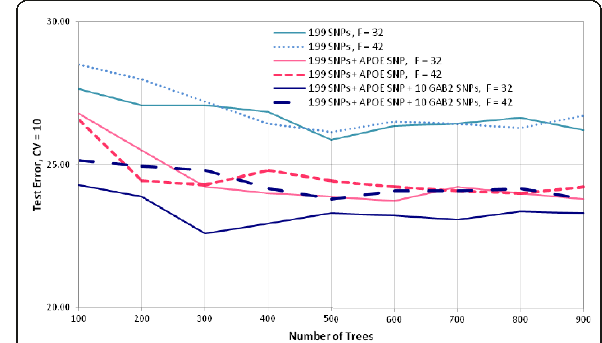
table SA. Some of the genes linked to the 199 SNPs appear among genes previously identified in GWAS as posted in the AlzGene database [10]. Furthermore, some of the top 199 SNPs are novel SNPs part of or in proxi- mity (may be acting as flags) to genes that may be engaged in a cascade of events leading to AD. Some of these genes and their relevance to AD are discussed below.